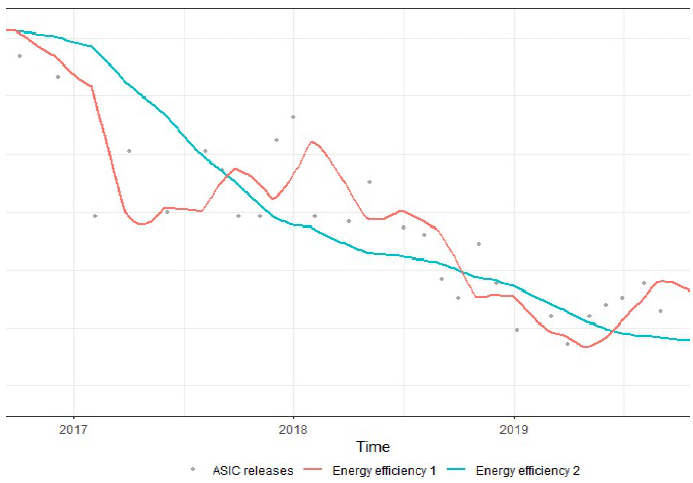
Figure 3. Energy efficiency curves estimated with models 1 and 2 in (4) for the whole Bitcoin network, and the respective ASIC releases. The reported data are measured in